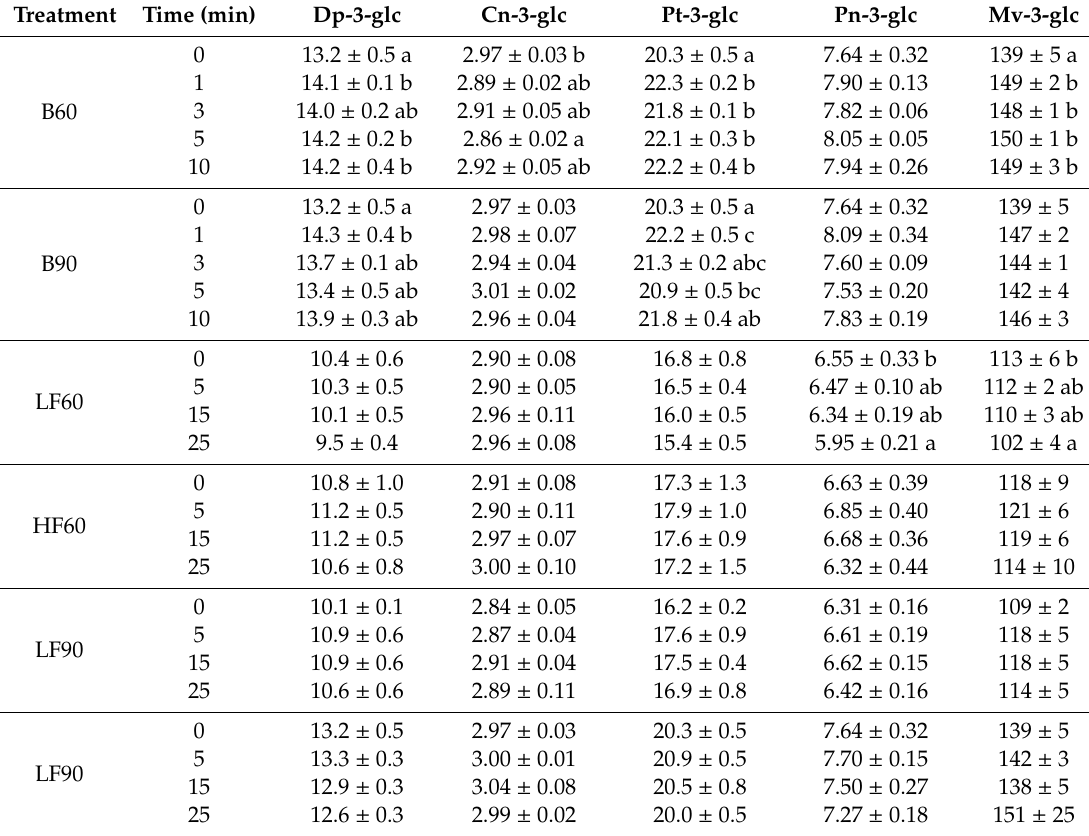
Table 4. Average non-acylated anthocyanins (mg / L) wine with di ff erent Argon APCP treatments and the standard deviation of data ( n =